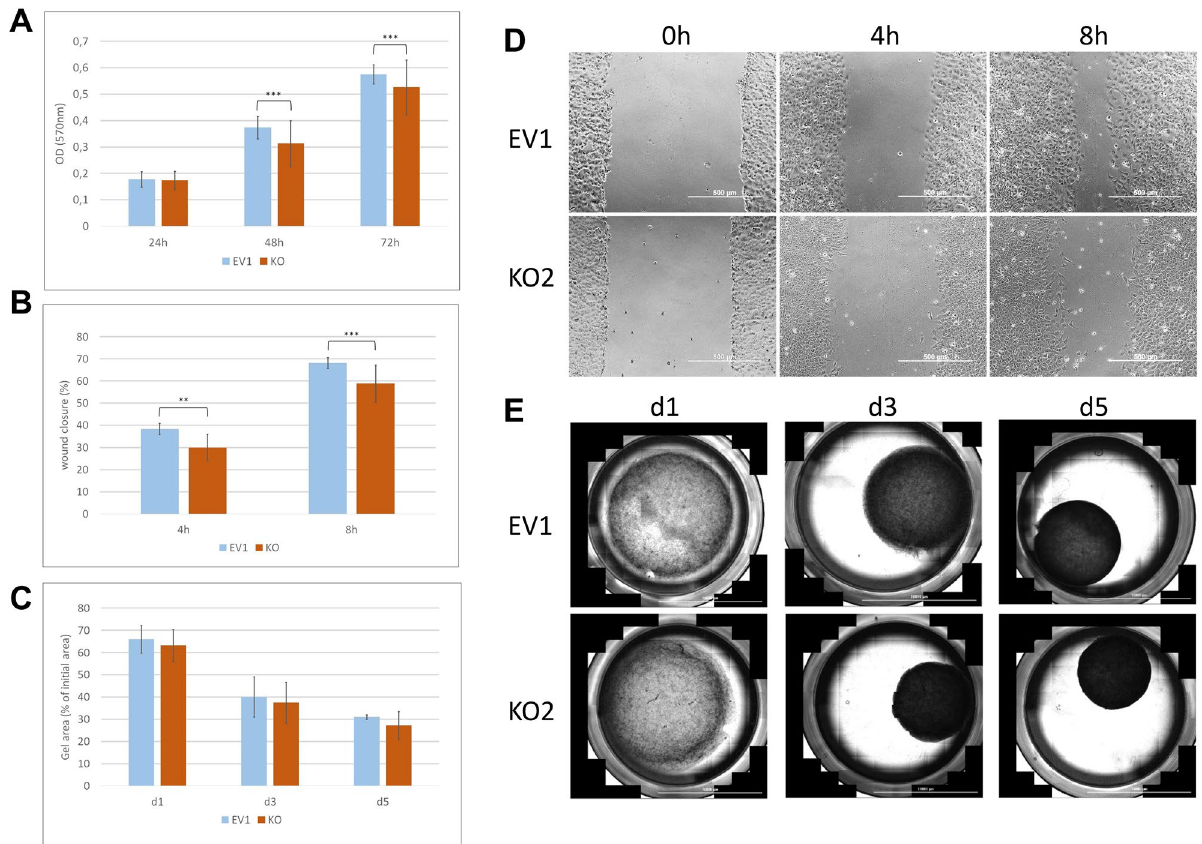
Figure 4. Functional analysis: ( A ) Proliferation assays of SERPINB2 knock-out (KO) and control (EV1) clones. ( B ) Scratch assays of SERPINB2 knock-out (KO) and control (EV1) clones. An example is shown in D. ( C ) Contraction assays of SERPINB2 knock-out (KO) and control (EV1) clones. An example is shown in E. Data are pooled from three experiments of the EV1 control clone and three knock-out clones. ** p < 0.01; *** p <